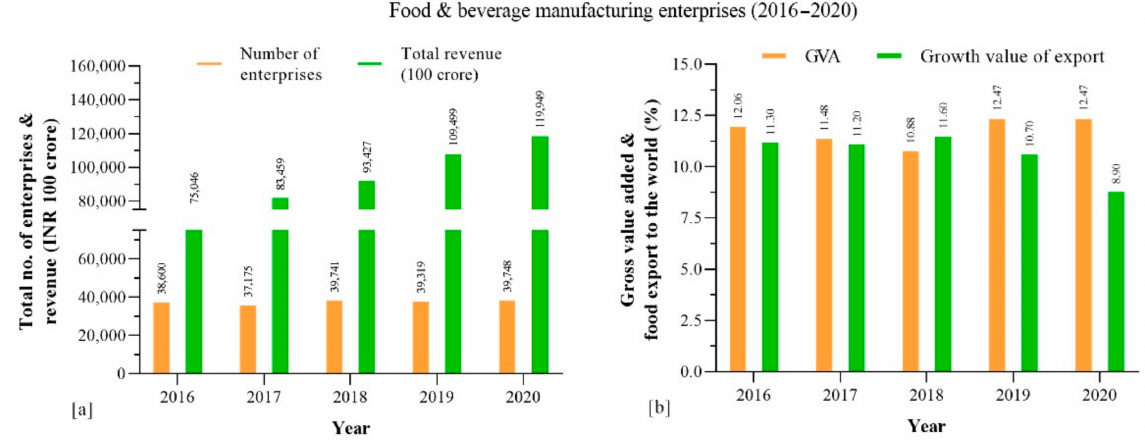
Figure 8. Food and beverage manufacturing enterprise in India (2016–2020). ( a ) Total number of enterprises and total revenue (INR 100 crore). ( b ) Gross value added and growth of export